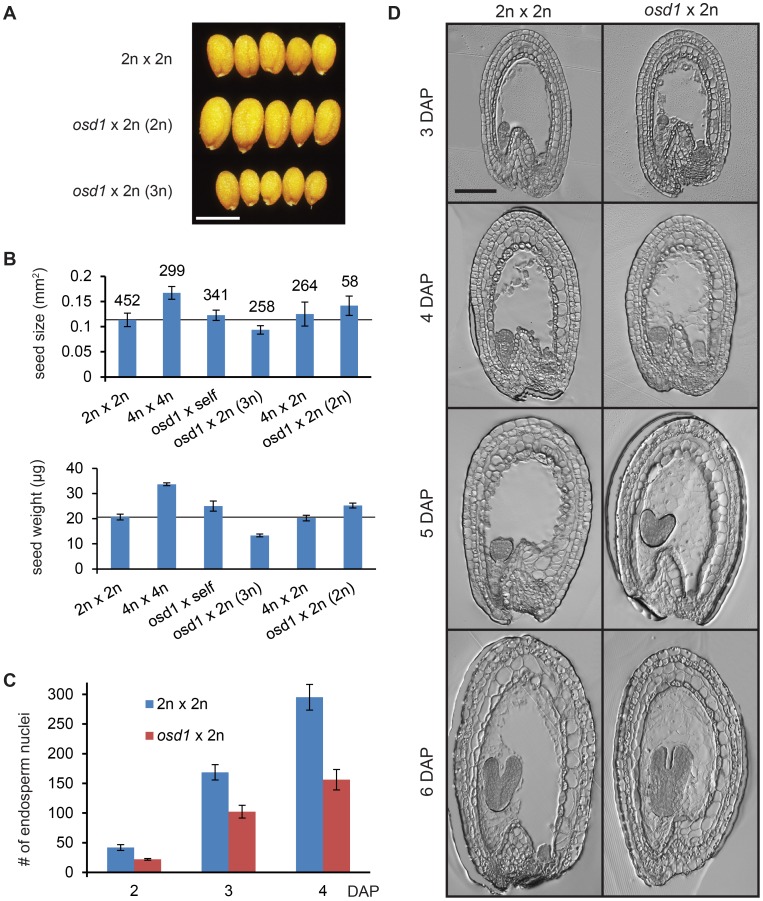
Seeds Derived from Crosses osd1×2n Mimic the Effect of Maternal Excess Interploidy Hybridizations.(A) Seeds from crosses of Col 2n×2n (upper panel) and osd1×2n (diploid and triploid seeds, middle and lower panel, respectively. Ploidy refers to ploidy of the embryo). Bar = 0.5 mm. (B) Average seed size (upper panel) and seed weight (lower panel) of different crosses. Numbers on top of bars correspond to number of analyzed seeds. For seed weight the average of 100 seeds was calculated in triplicates. Error bars indicate SD. The reference line corresponds to wild-type seed size and weight. (C) Number of endosperm nuclei in Col 2n×2n and osd1×2n crosses. n = 5. Error bars indicate SD. (D) Sections of seeds from Col 2n×2n and osd1×2n crosses. Bar = 100 µm.